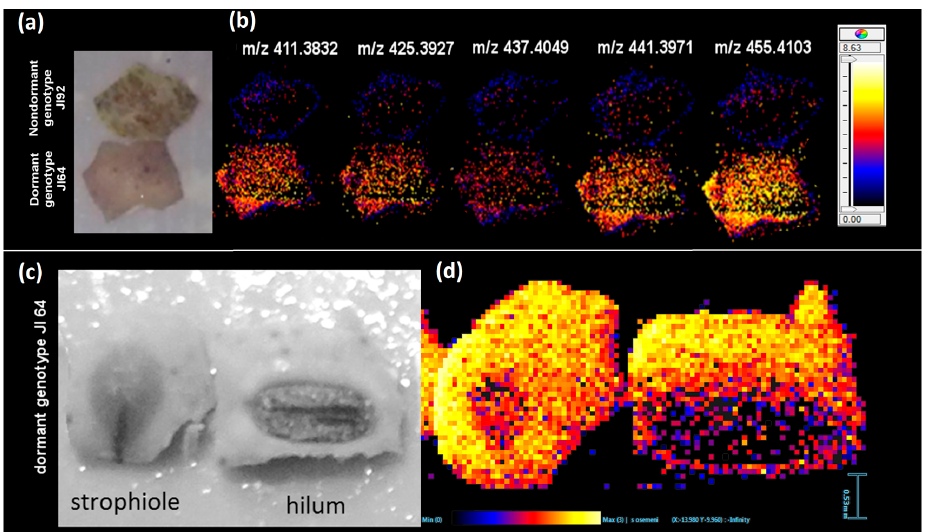
Figure 4. LDI-MSI analysis of external seed coat surfaces. ( a ) Optical image of analyzed seed coats used for mass imaging; ( b ) comparison of distribution of signals ( m / z values) of hydroxylated fatty acids on seed coat of dormant JI64 (bottom mass images) and non-dormant JI92 (upper mass images); ( c ) optical image of parts of JI64 seed coats containing strophiole and hilum used for mass imaging; ( d ) distribution of dihydroxyoctacosanoate ( m / z 455.4103) over the external surface containing strophiola and hilum; matrix free MSI measurement. Colors in the mass images, i.e., ( b , d ), correspond with intensity of particular HLFA markers (their amounts on seed coat surface) in MS spectra (yellow reflects the highest signal and black the lowest one as displayed by inserted color scales).